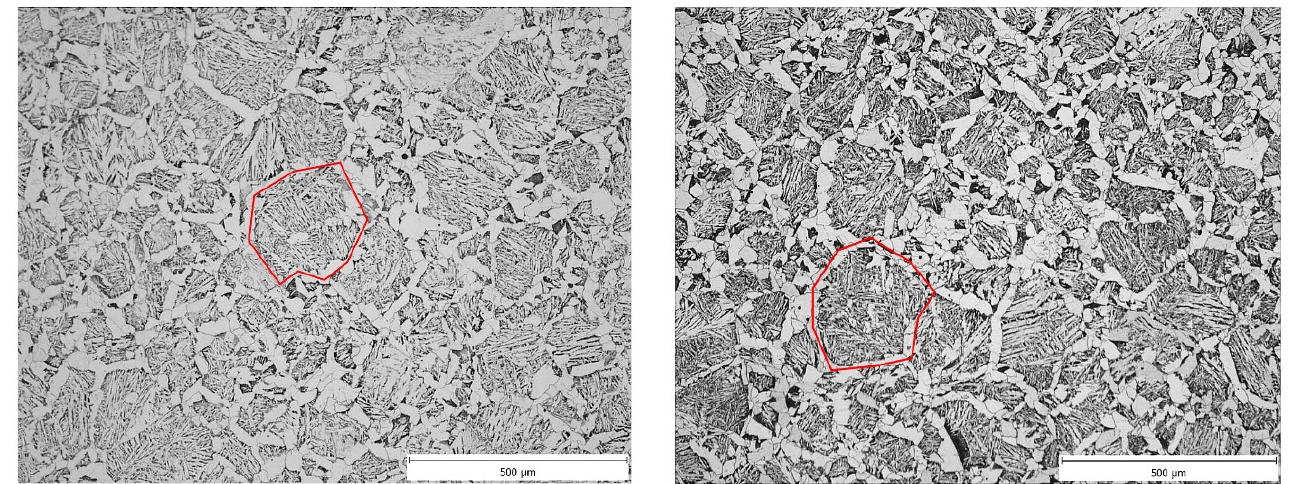
11 of 24 Figure 12. Marking of microstructure documentation sites (sample: variant 1). V1–V4 represent the areas of detailed microstructural analysis. In general, the microstructure in the undeformed part of all samples was comparable: